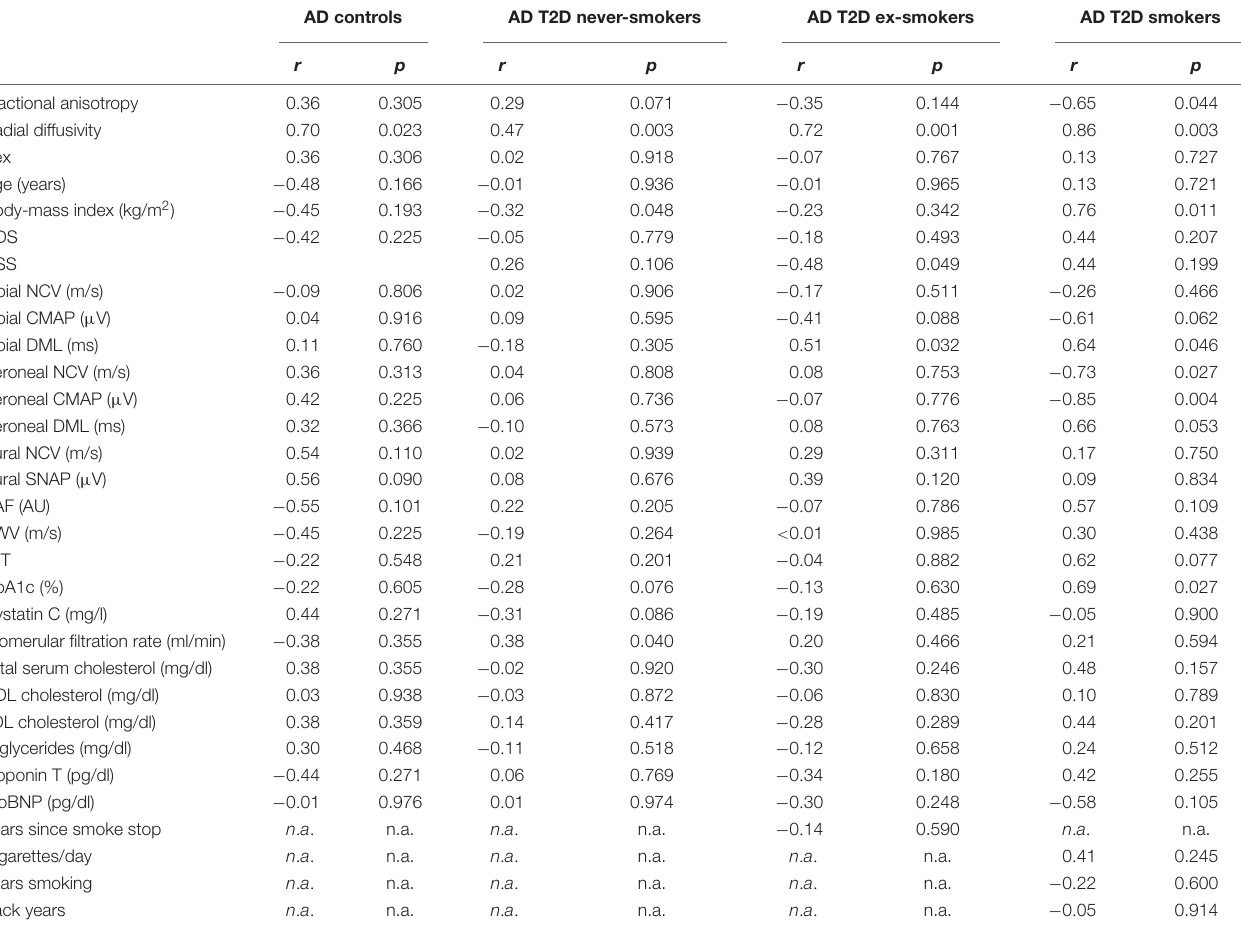
TABLE 4 | Correlation of the sciatic nerve’s axial diffusivity (AD; in 10 − 5 mm 2 /s) with demographic, clinical, apparatus-bound, and serological parameters. AD controls AD T2D never-smokers AD T2D